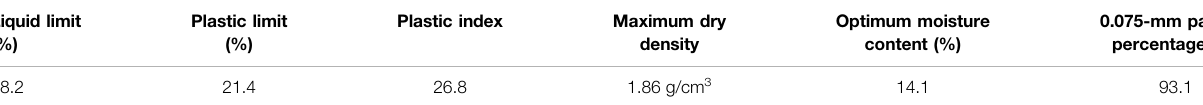
TABLE 1 | Main basic physical properties of the tested soils.